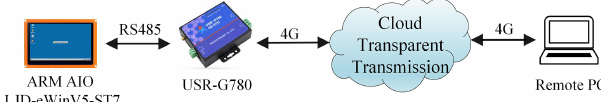
Figure 7. Connection topology.